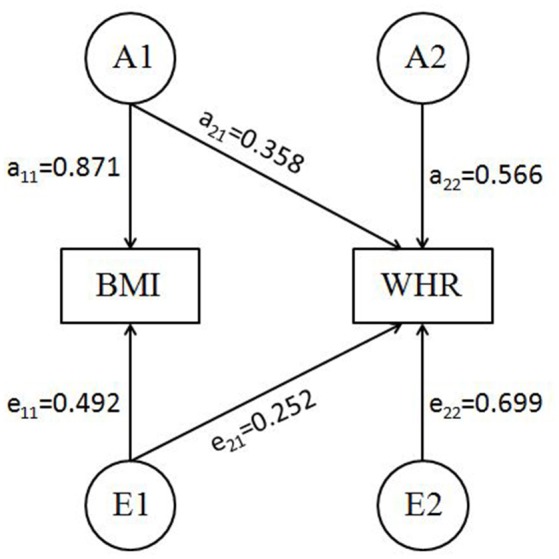
Best bivariate model (AE model) for BMI-WHR with standardized path coefficients (SEM pathway plot). A1, A2 = genetic variance components; E1, E2 = unique environmental variance components; a11 through a22 = genetic path coefficients of which a22 represents specific genetic influence on WHR; e11 through e22 = unique environmental path coefficients, of which e22 represents specific unique environmental influence on WHR.